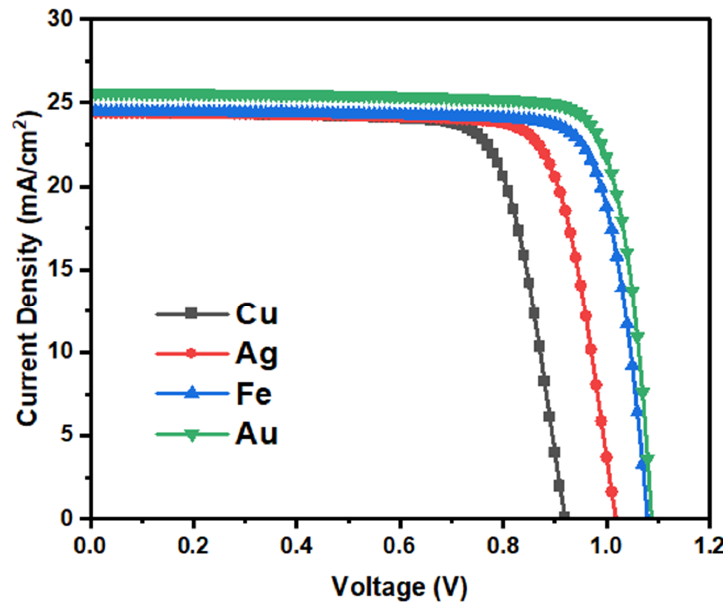
Figure 12. Comparison of the current density-voltage ( J–V ) behavior for different work functions of back contact.